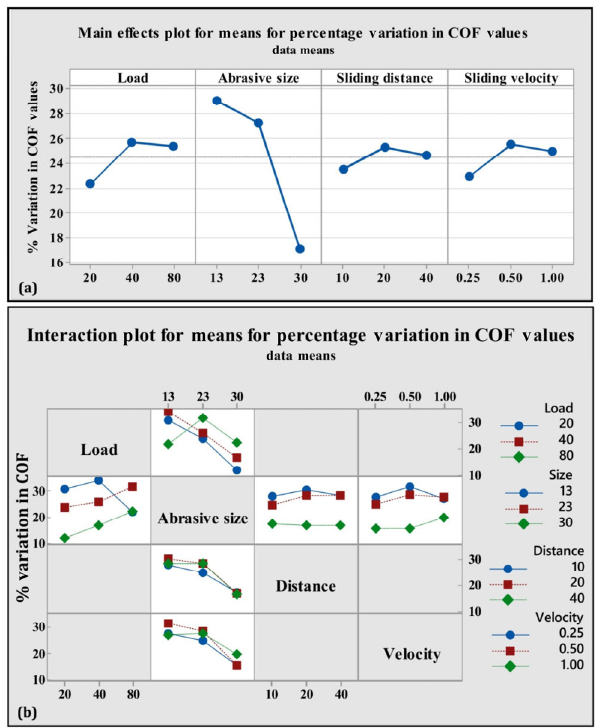
Fig. 9 (a) Main effects plots for means and (b) interaction plots of percentage variation in coefficients of friction between alloy and composite, abbreviated as ∆ COF(%) in the present